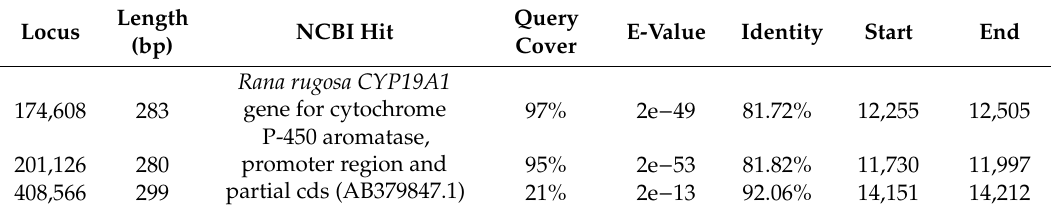
Table 2. Blast results of nonredundant nucleotides from the NCBI